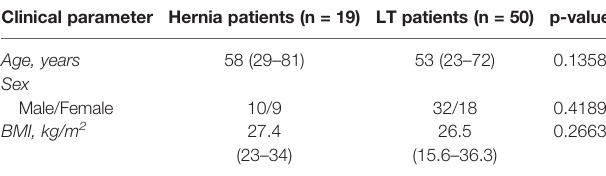
TABLE 2 | Baseline characteristics of the control group and LT